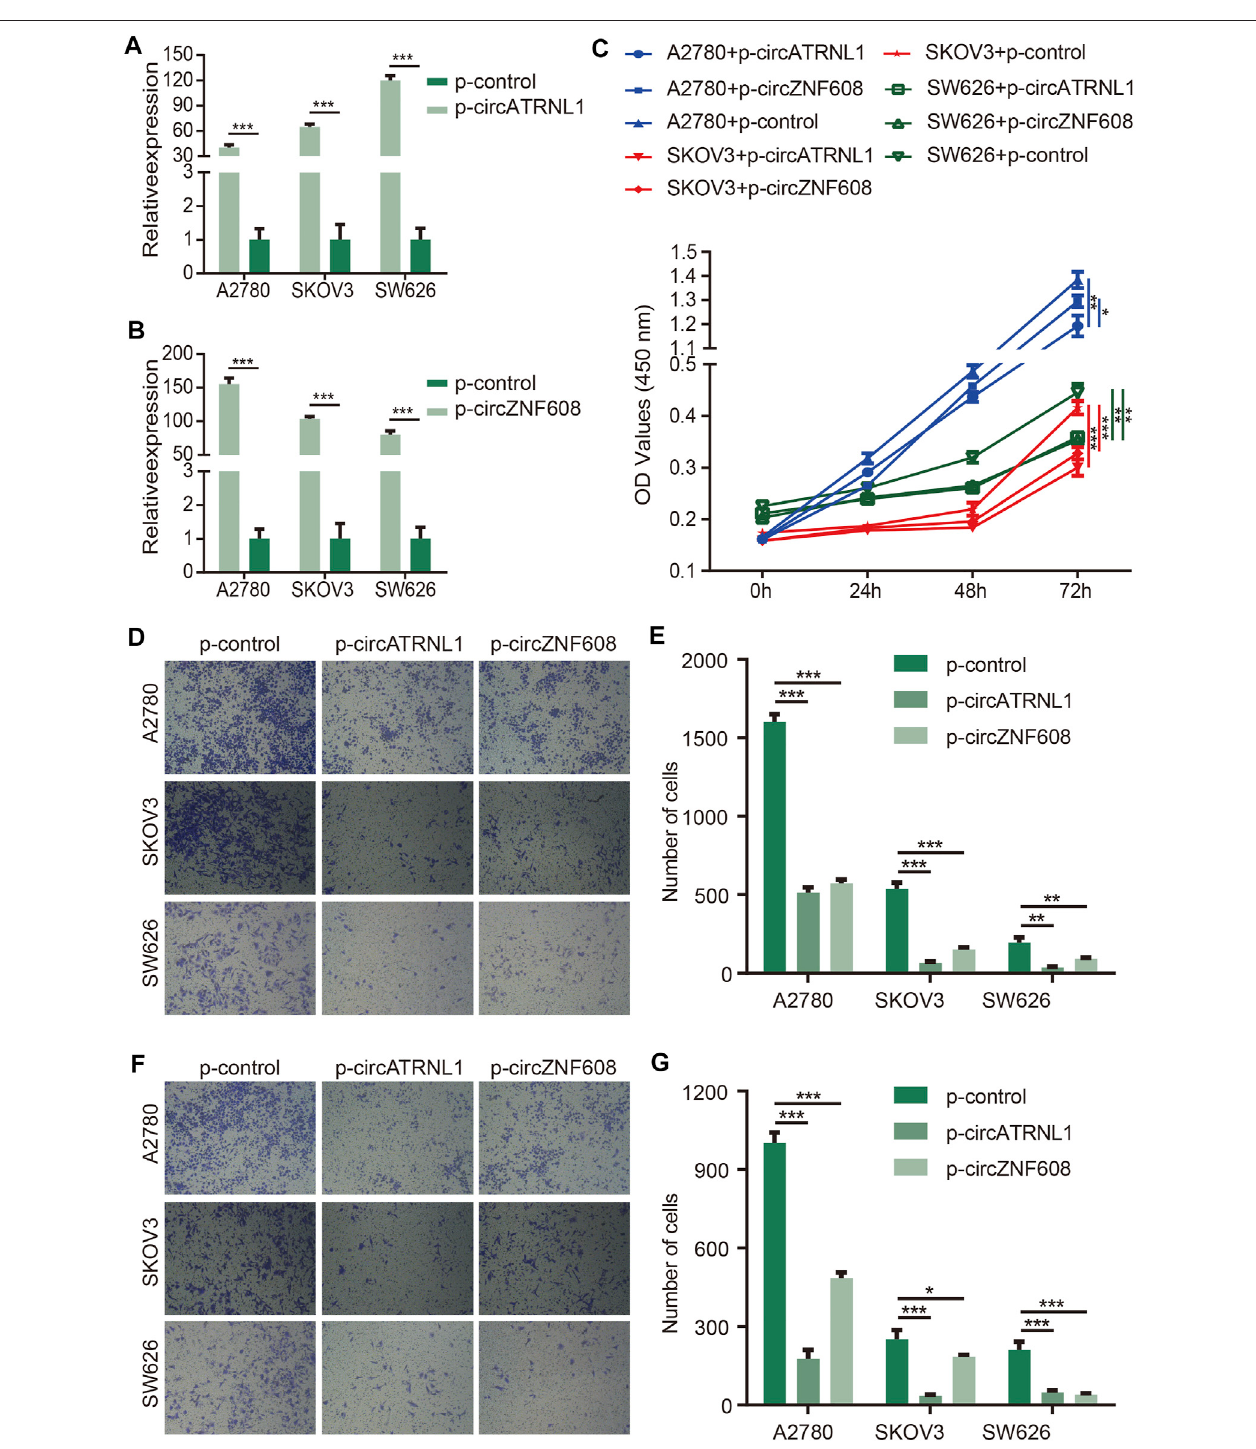
FIGURE 2 | circATRNL1 and circZNF608 overexpression inhibited ovarian cancer cell proliferation and invasion. (A) circATRNL1 was overexpressed after transfecting p-circATRNL1. (B) circZNF608 was overexpressed after transfecting p-circZNF608. (C) circATRNL1 and circZNF608 inhibited the proliferation of ovarian cancer cells. (D) Representative pictures of the transwell migration assay. (E) circATRNL1 and circZNF608 decreased the migration of ovarian cancer cells. (F) Representative pictures of the transwell invasion assay. (G) circATRNL1 and circZNF608 decreased the invasion of ovarian cancer cells. p-circATRNL1, plasmids expressing circATRNL1; p-circZNF608, plasmids expressing circZNF608, p-control, control plasmids; * p < 0.05; ** p < 0.01; and *** p < 0.001.